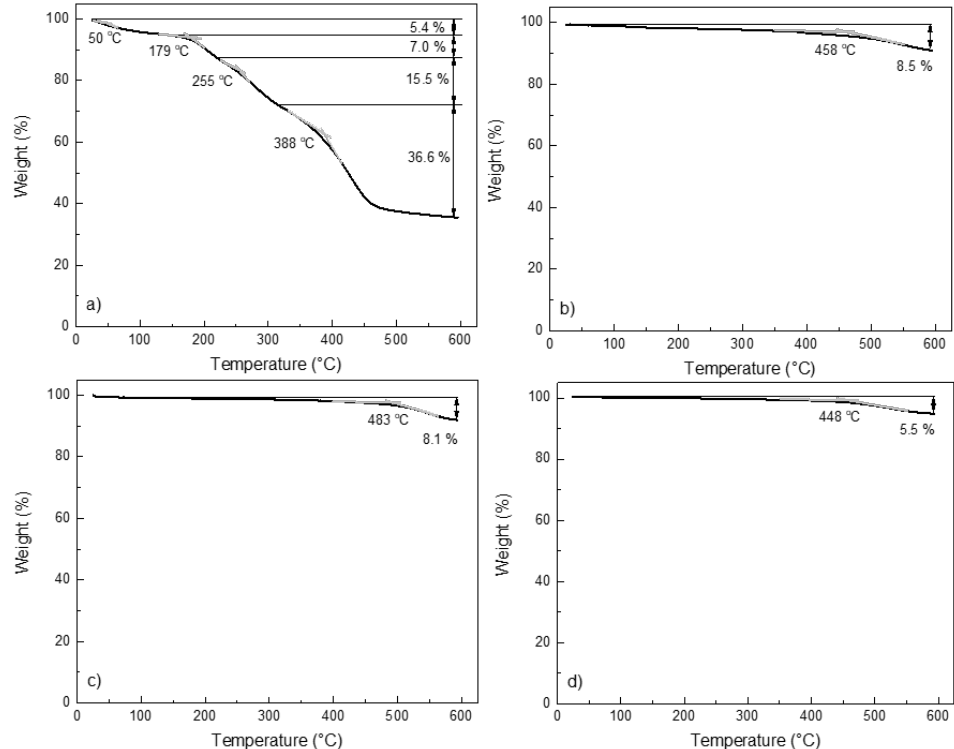
Figure 5. TGA of the rubber-silica aerogel composites reinforced with ( a ) recycled tire textile fibers; ( b ) polyester fiber blanket; ( c ) silica fiber felt; and ( d ) glass wool.